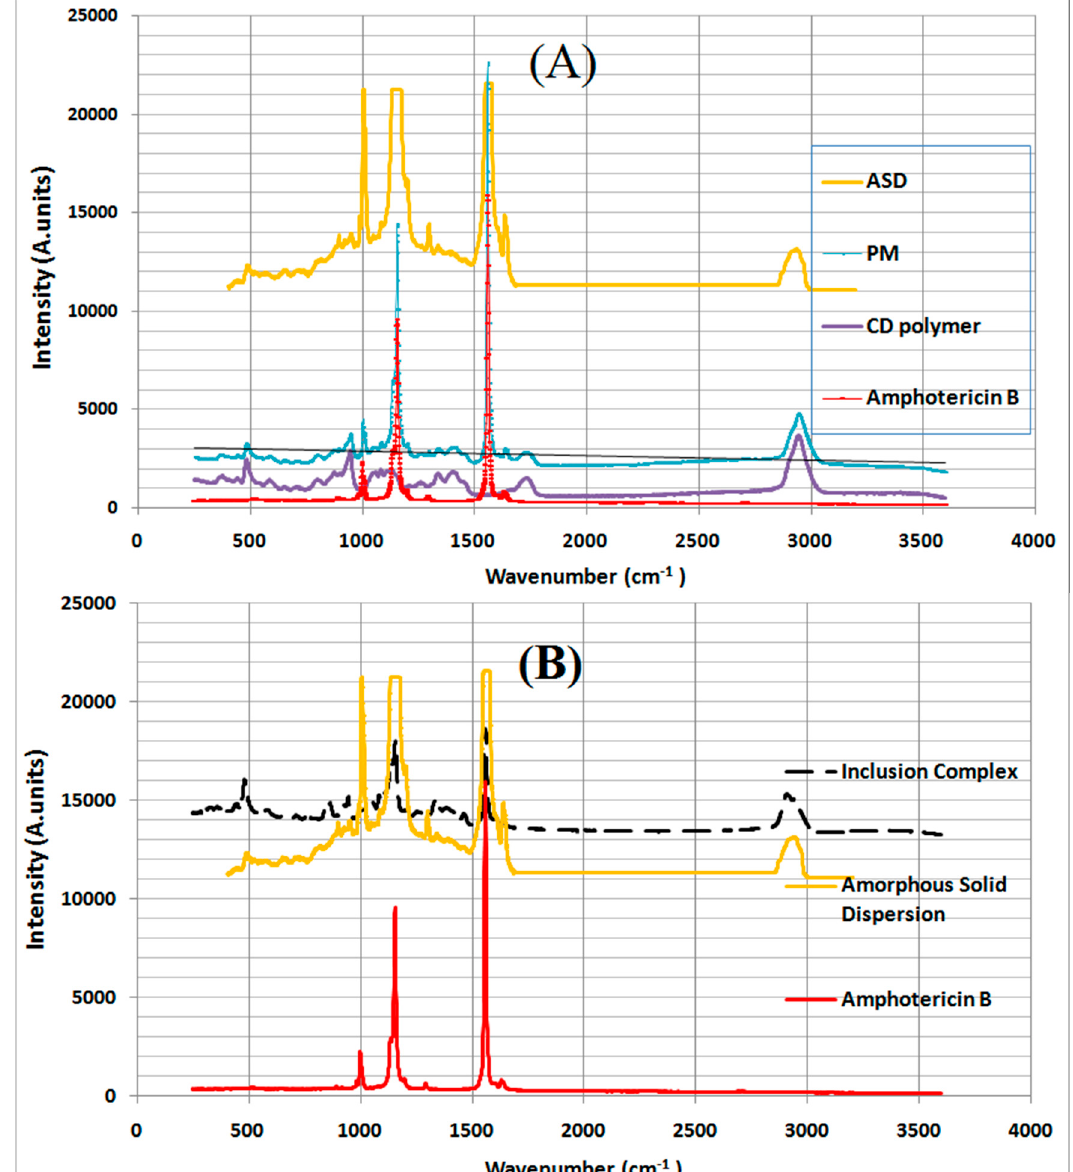
Figure 6. ( A ) Raman spectra of amphotericin B, cyclodextrin polymer (Poly- γ -CD), physical mixture (PM) and amorphous solid dispersion (ASD). ( B ) Raman spectra of amphotericin B, ASD and inclusion complex.